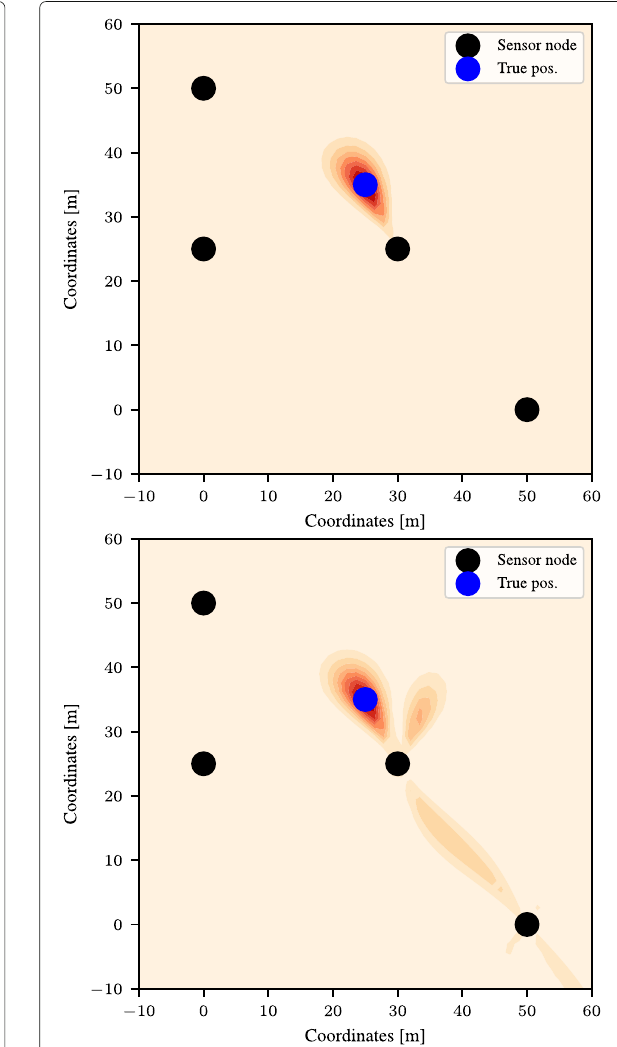
Fig. 12 Likelihoods for example network localization scenario 1 for the unambiguous DOA sensor and the BATS DOA sensor. True position of the tracked object is at [25,35]. a Unambiguous bearing. b Ambiguous bearing